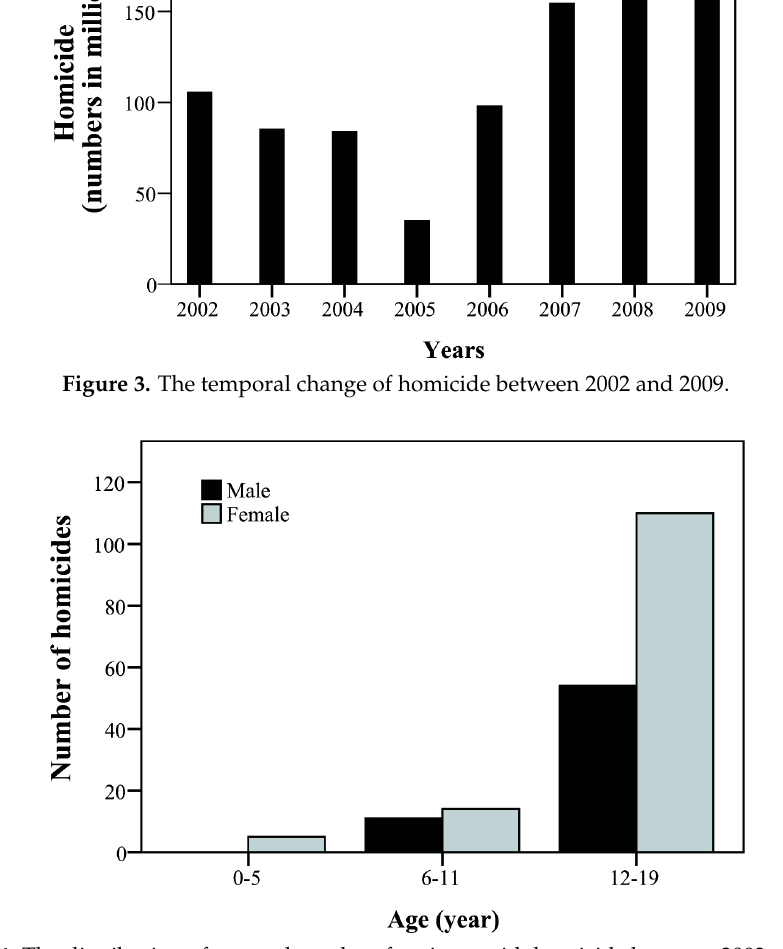
Figure 4. The distribution of age and gender of patients with homicide between 2002 and 2009.